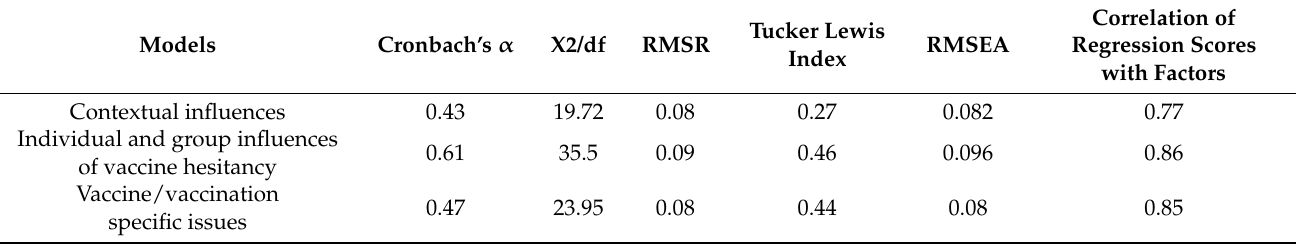
Table 5. Exploratory factor analysis model fit for the three